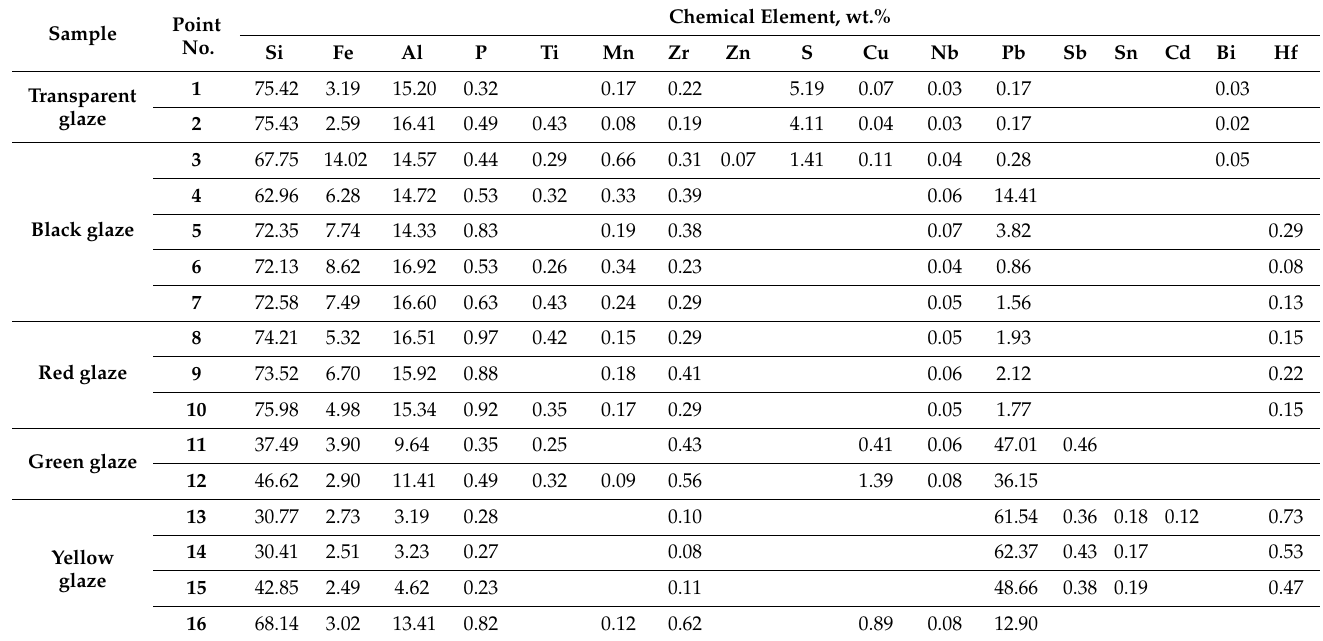
Table 2. In order to interpret the obtained data correctly, chemical elements with values ≥ 1.0% (wt) were taken into account. Table 2. pXRF data on the chemical elemental composition of